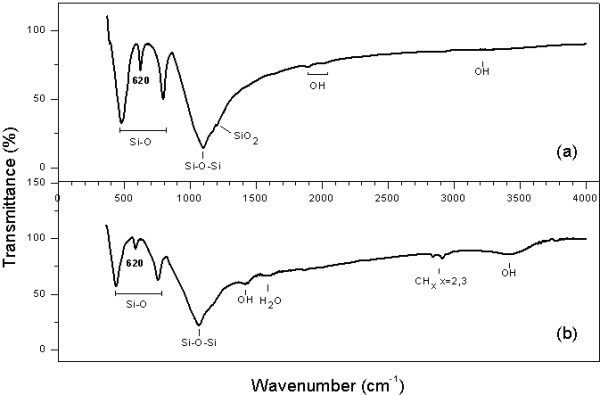
FTIR transmittance spectra of opals nanoparticles: a) O1 and b) O2. Identification of characteristic absorption band at 620 cm−1, attributed to the crystalline opal (opal-C) for both samples.